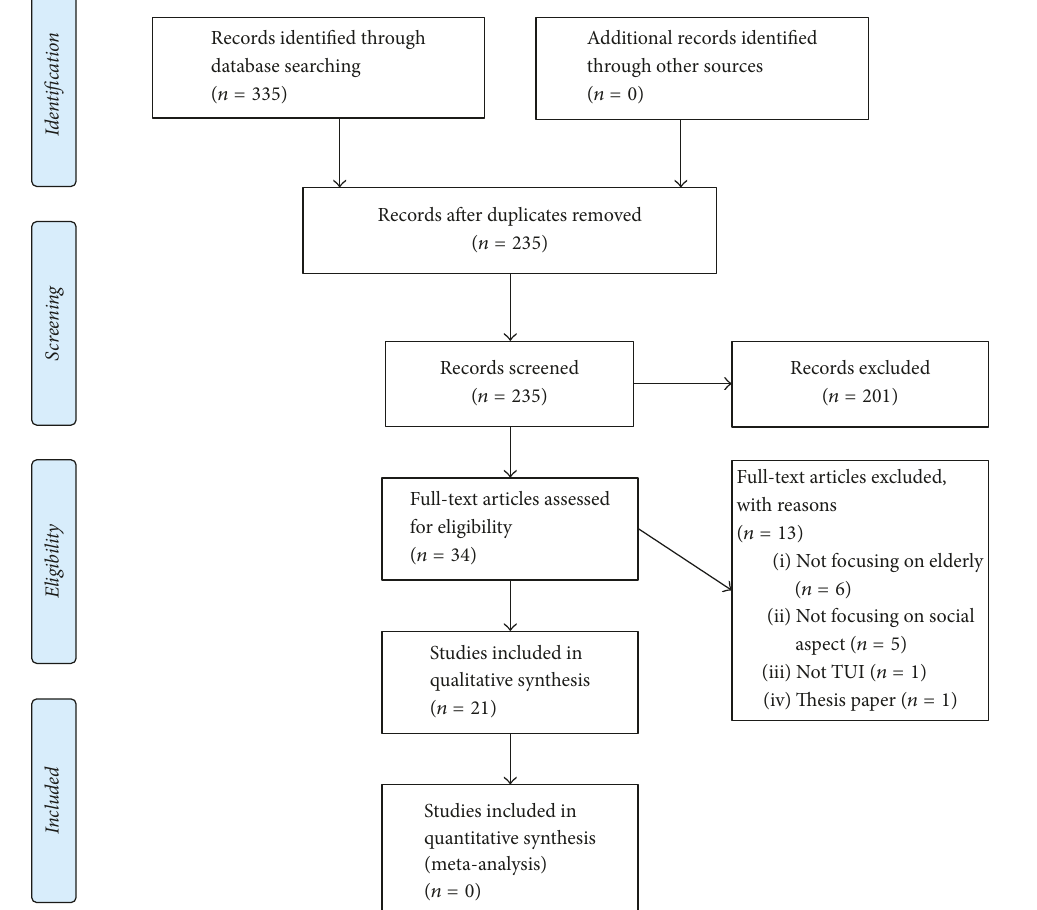
Figure 3: Process of review using a PRISMA flow diagram.